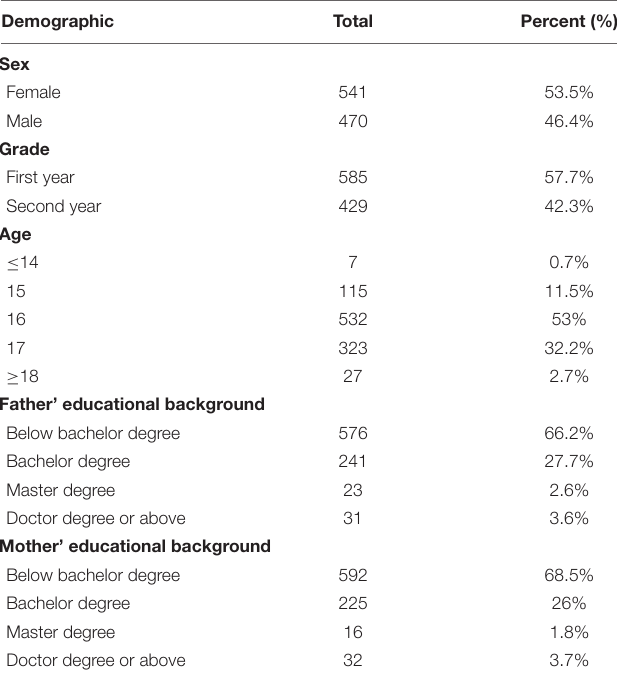
TABLE 1 | Demographic information of the